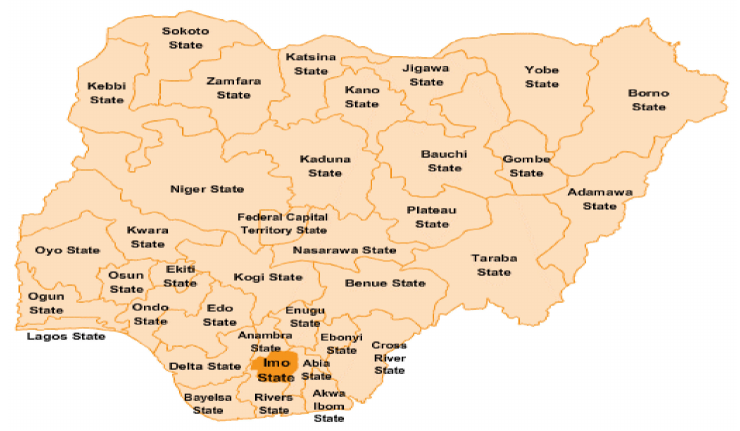
Figure 1. Map of Nigeria. (Source: google.com. Images for map of